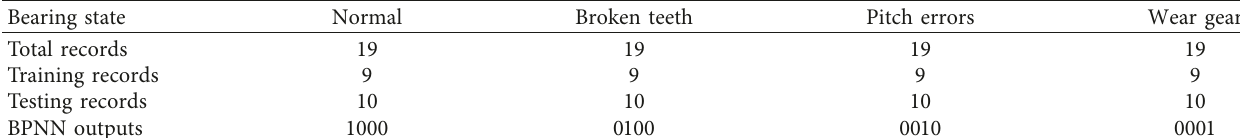
Table 8: Number of records per gear state and BPNN outputs.